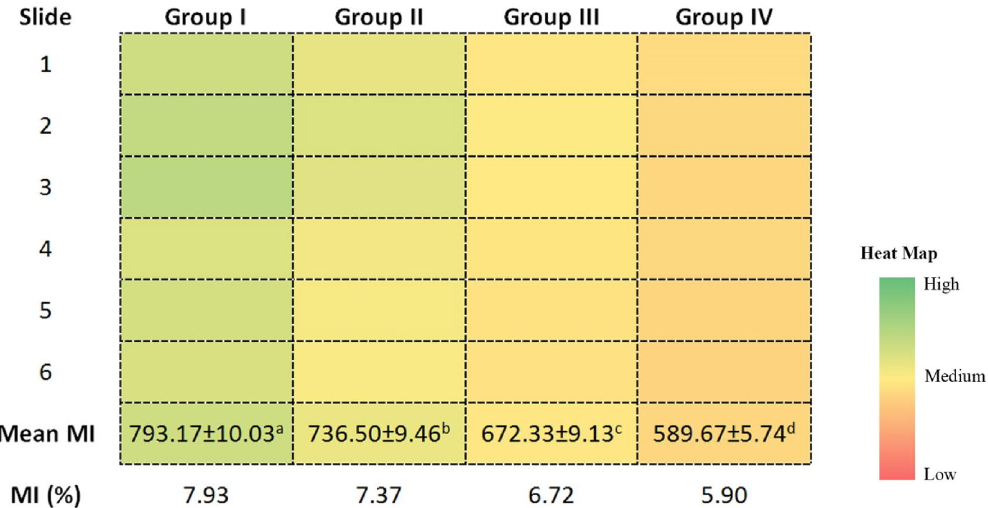
Figure 5. The effects of cypermethrin on MI. *Group I: control, Group II: 62.5 mg/kg b.w cypermethrin, Group III: 125 mg/kg b.w cypermethrin, Group IV: 250 mg/kg b.w cypermethrin. MI was calculated by analyzing 1000 cells per animal (for a total 6000 cells per group). Values are shown as mean ± SEM (n = 6). Data were analyzed with SPSS computer program using Duncan test and ANOVA variance